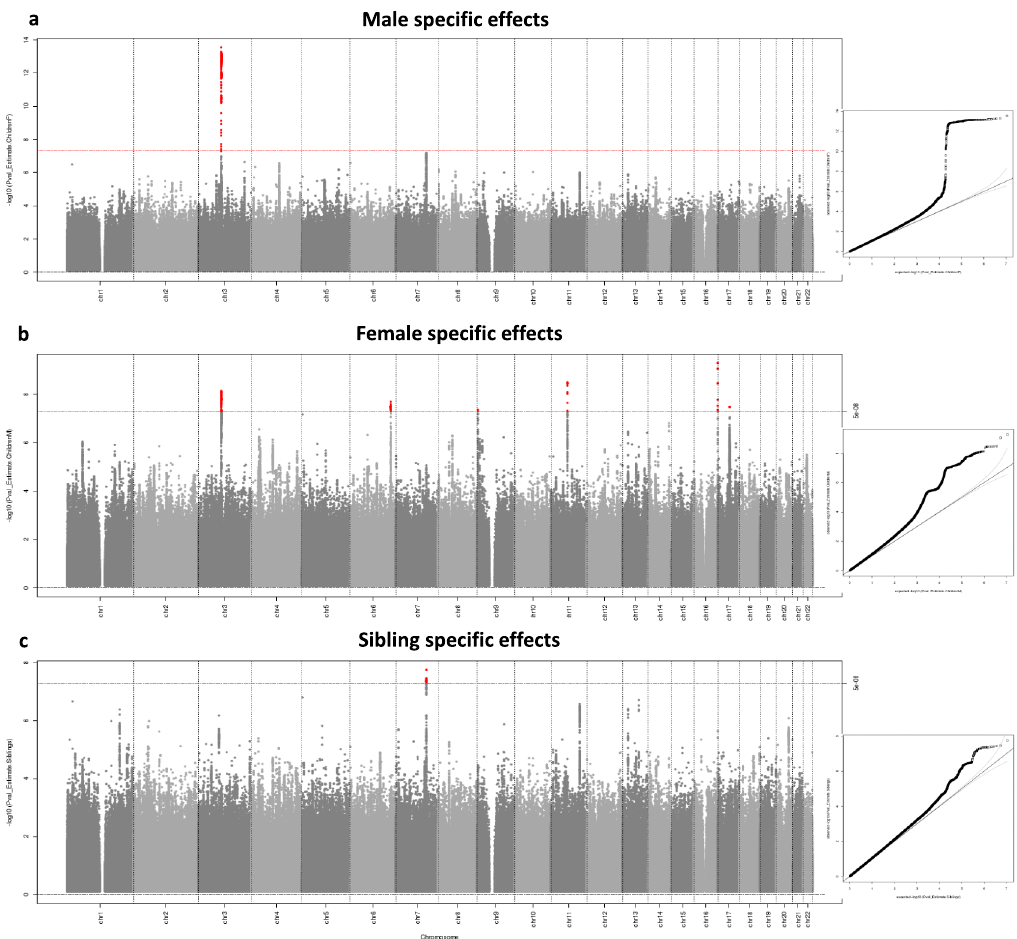
Fig. 3 Manhattan plot and quantile – quantile (Q – Q) plot for the fertility GWAS estimating male, female and sibling-speci fi c genetic effects using Genomic SEM. 237,768 women from the UK Biobank contributed to the unconditional GWAS of the number of children mothered, 199,570 men contributed to the GWAS of the number of children fathered and 430,466 individuals contributed to the GWAS of the number of siblings (see Supplementary Fig. 26 for the Manhattan plots of the unconditional GWAS). Point estimates for male, female and sibling effects and their standard errors were estimated using diagonally weighted least squares as implemented in Genomic SEM, and two-sided P -values obtained from Z tests on these estimates. The two-sided association P -value, on the − log10 scale, obtained from Genomic SEM for each of the SNPs ( y -axis) was plotted against the genomic position (NCBI Build 37; x -axis). Association signals that reached genome-wide signi fi cance ( P < 5 × 10 − 8 ) are shown in red. In the Q – Q plots, the black dots represent observed two-sided P -values and the grey line represents expected two-sided P -values under the null distribution. The SNP heritability, estimated using LD score regression, was 0.033 (SE = 0.003) for male fertility, 0.042 (SE = 0.003) for female fertility and 0.012 (SE = 0.001) for sibling-speci fi c effects. P -values are not adjusted for multiple